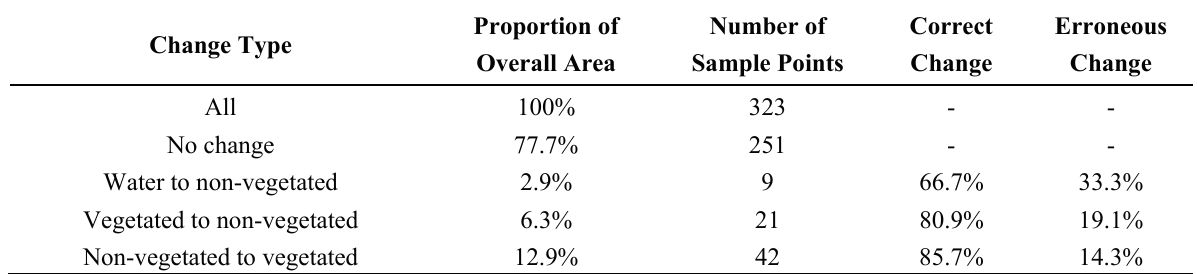
Table 1. Stratified point sampling and results of the visual assessment of change correctness.